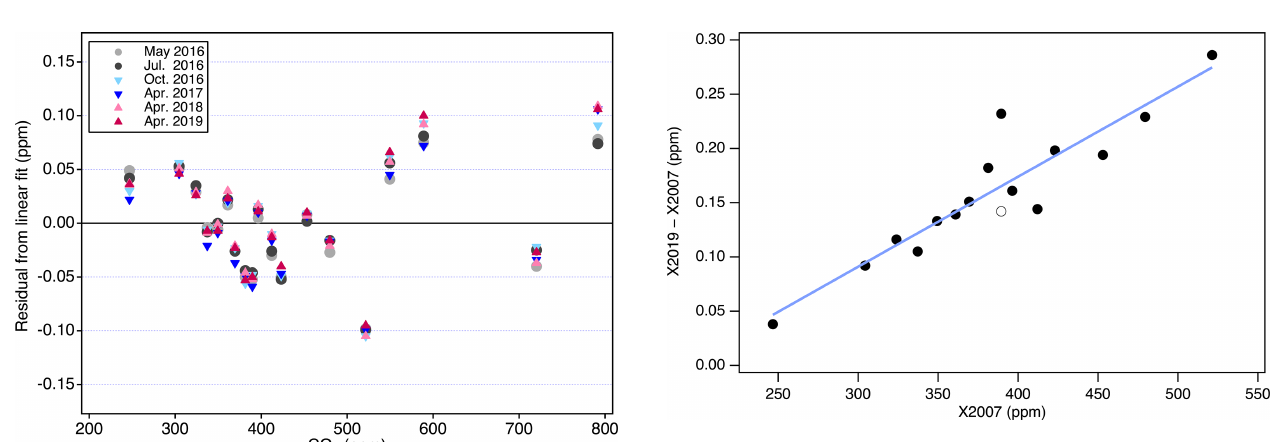
Figure 10. Differences between X2019 and X2007 assignments for the 15 primary standards used to define scale X2007 (black sym- bols) and the best-fit line (blue line). The open symbol corresponds to primary AL47-146 with value 389.64ppm (we used 389.55ppm in 2007 by